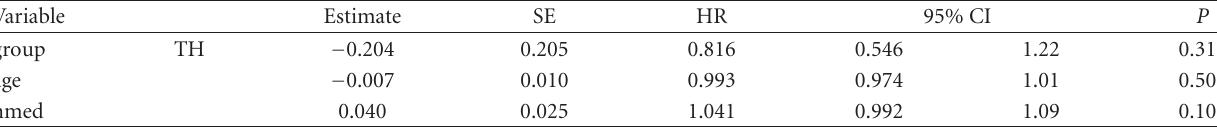
Table 3: Results from cox proportional hazards modeling of time to first all-cause readmission or death.